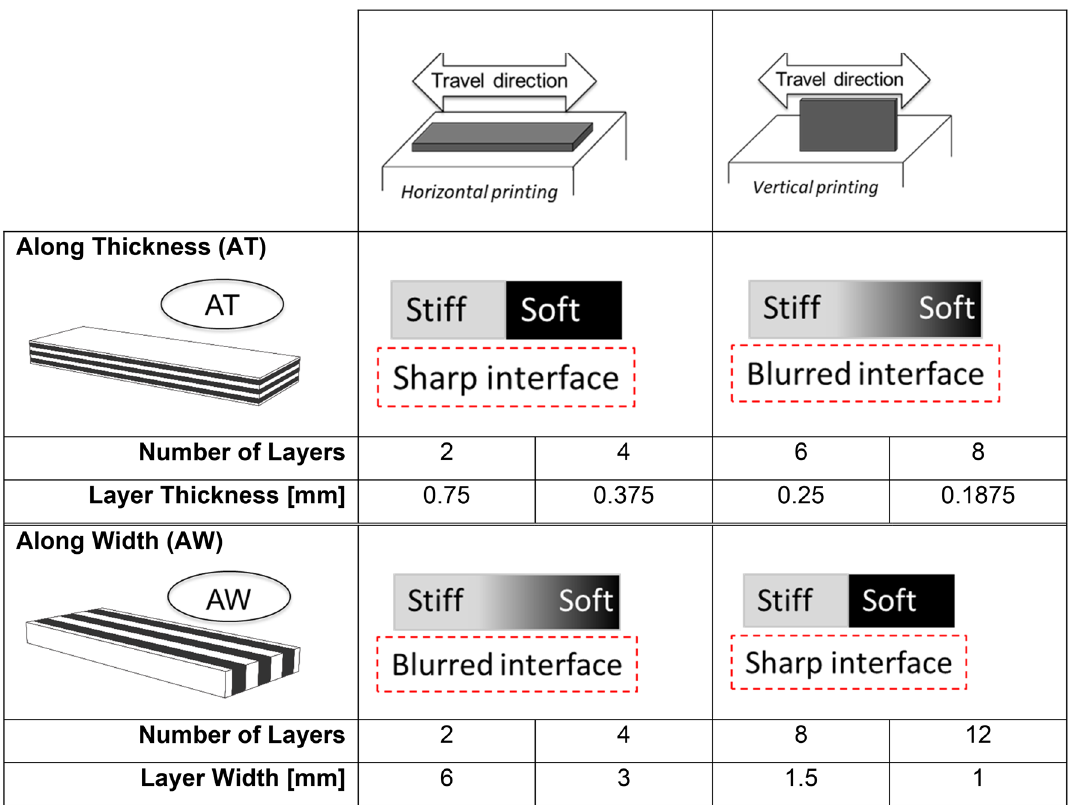
Table 1. Simplified graphical summary linking layer position (along thickness/width), printing orientation (horizontal/vertical) and corresponding interface (blurred/sharp). The number of layers and corresponding layer dimensions are also